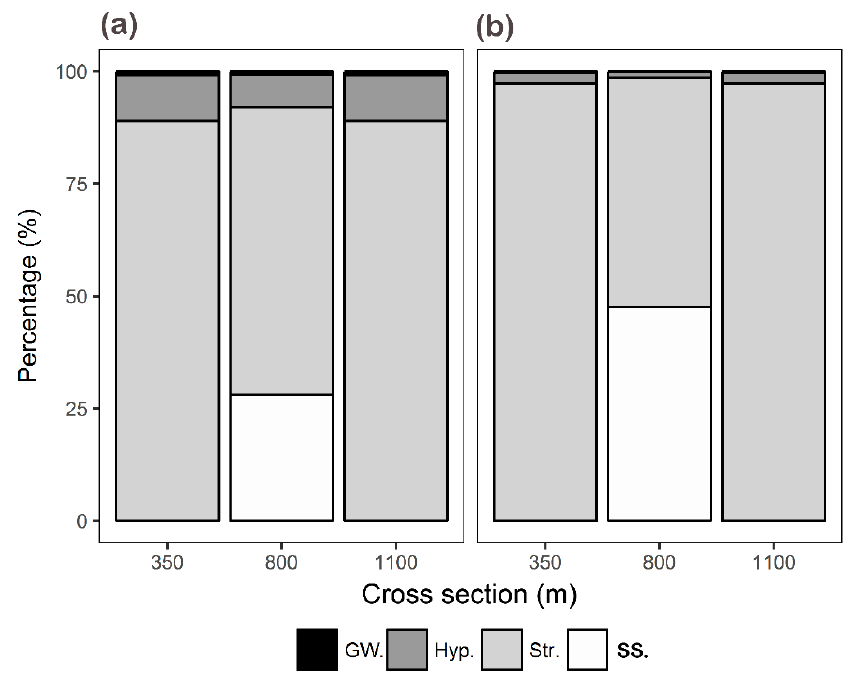
Figure 6. Simulated contribution to river temperature of the river flow (Str.), storm sewer (SS.), hyporheic exchange (Hyp.), and groundwater flow (GW.) in two timesteps including ( a ) before storm and ( b ) during the storm at three representative cross sections from the upper reaches (between cross sections at station 0 m and 600 m), middle reach (between cross sections at station 600 m and 900 m), and downstream reach (between cross sections at station 900 m and 1500 m).